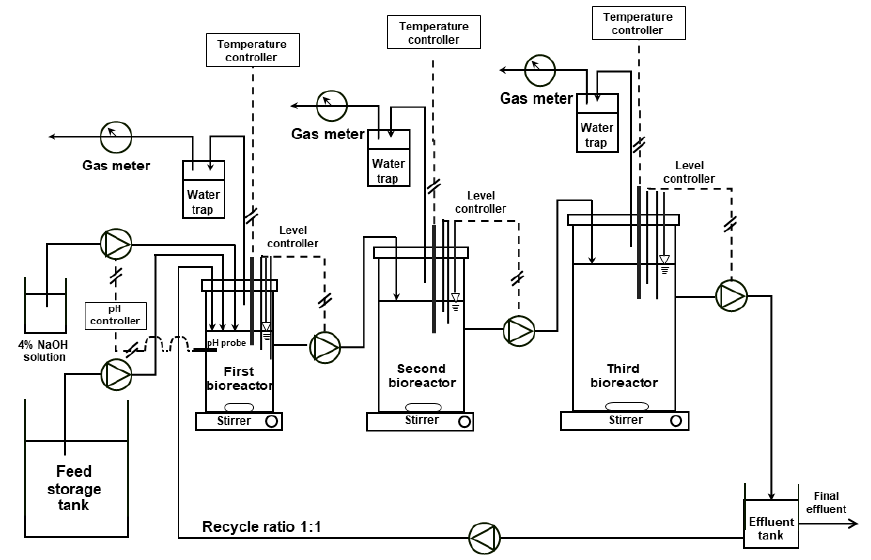
Figure 1. Schematic representation of the three-stage anaerobic sequencing batch reactor (ASBR) system .